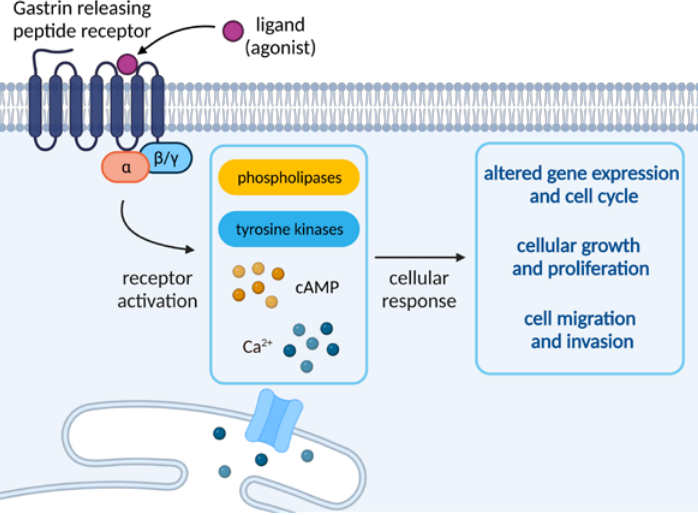
Figure 2. Overview of GRPR signaling. Created with BioRender.com.